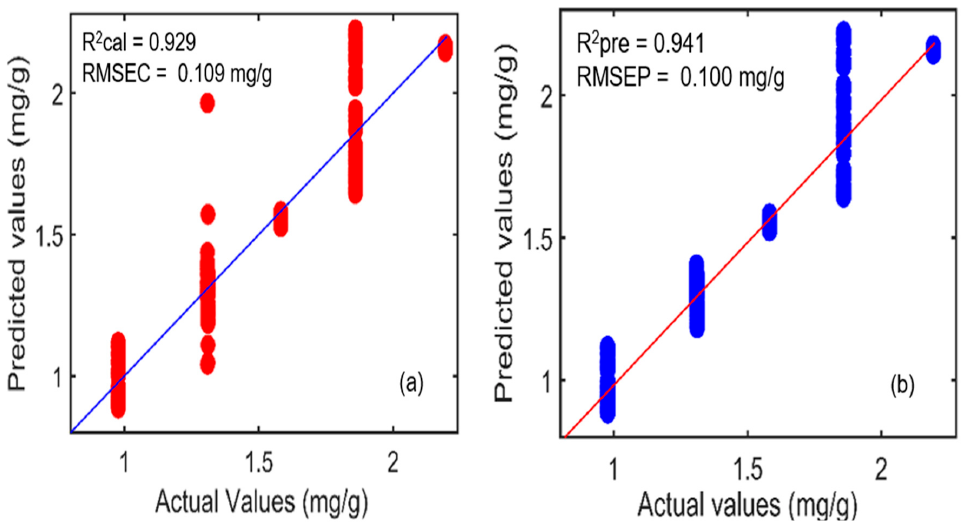
Figure 10. Hybrid linear analysis (HLA/GO) model for actual and predicted concentration values for the phenolic compounds in A. thaliana powder samples for ( a ) calibration and ( b ) prediction datasets. Table 5. Results from the developed PLSR, PCR, and HLA/GO models for the prediction of phenolic compounds in A. thaliana leaf powder samples using FT-IR spectroscopy.